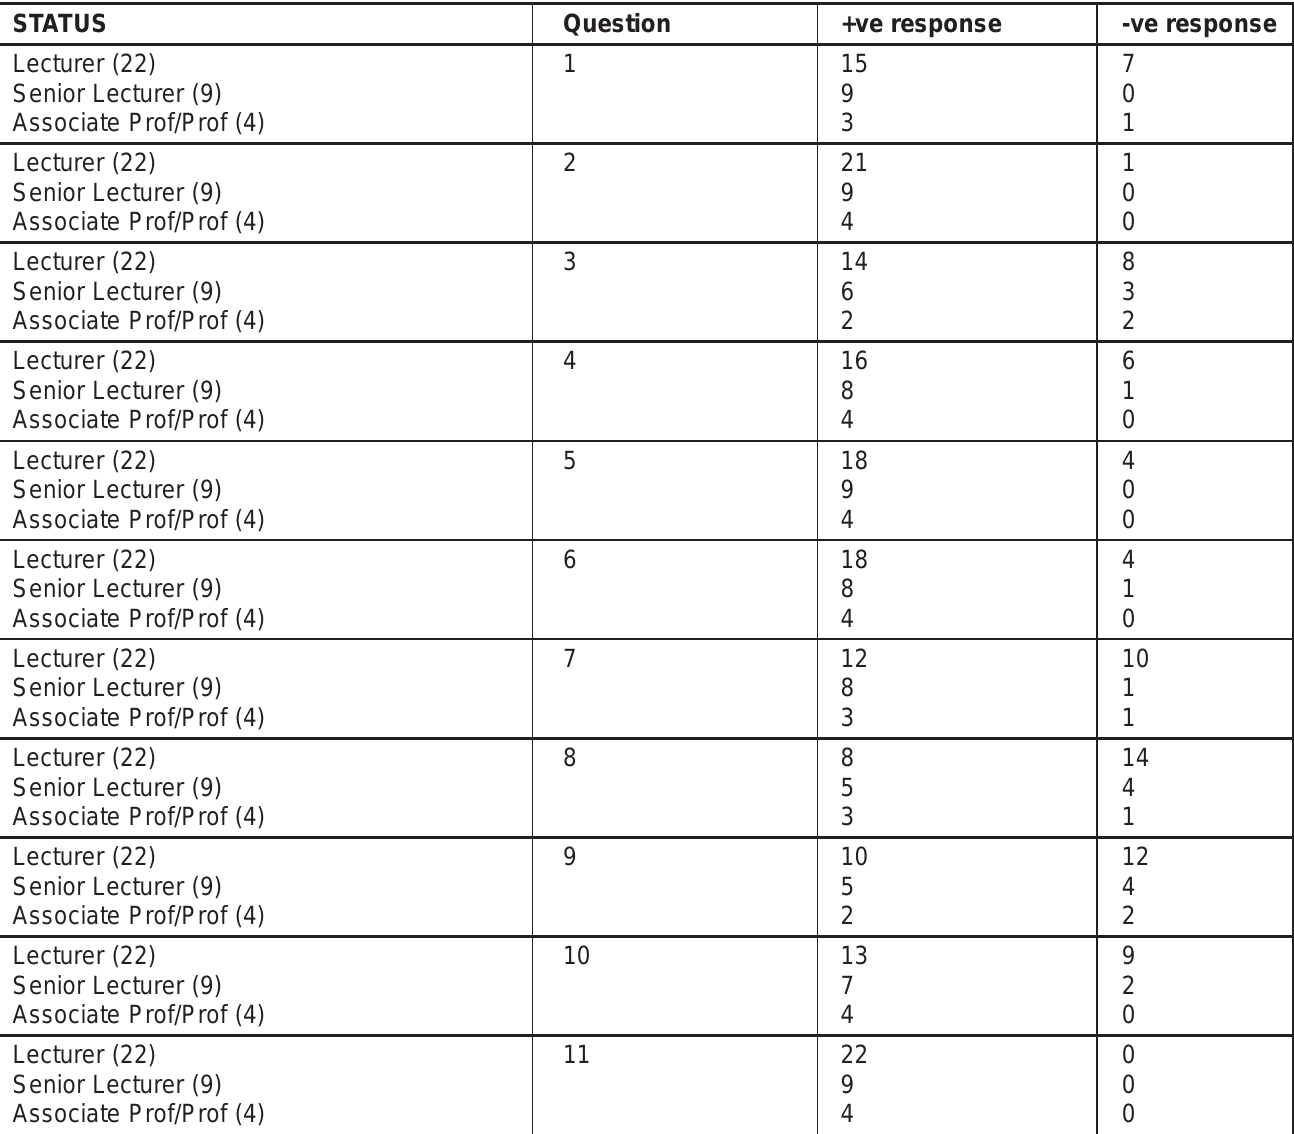
Table 3: Responses according to lecturer status